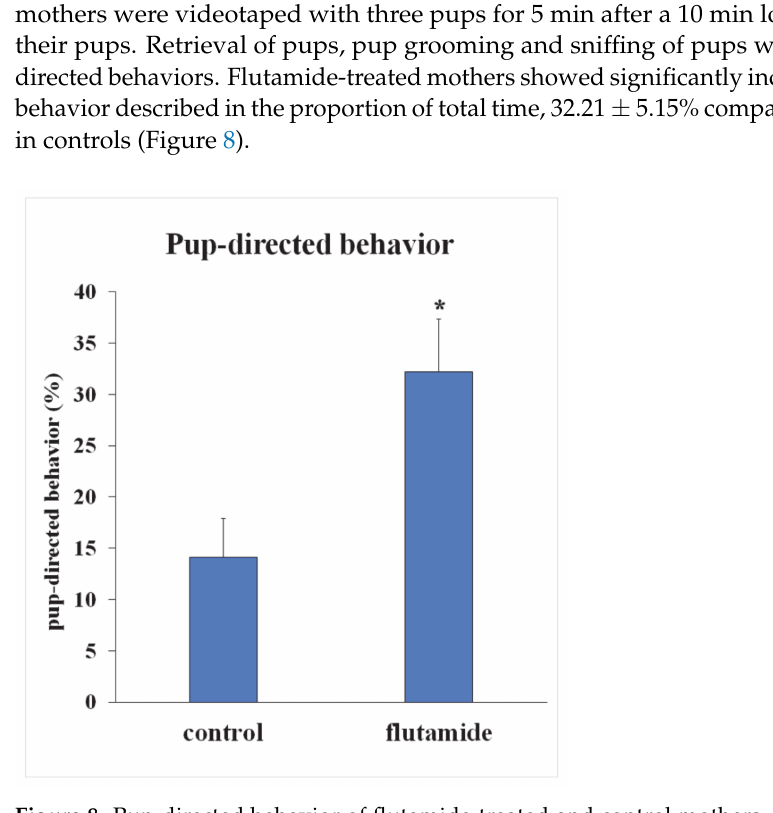
Figure 8. Pup-directed behavior of flutamide-treated and control mothers. Flutamide, a selective non-steroid antagonist of AR, was continuously administered icv. with a 0.5 mL/h speed via osmotic minipumps. One group of lactating mothers (n = 9) received flutamide and the control group (n = 9) received vehicle. On the sixth day postpartum, maternal behavior was analyzed. Retrieval of pups, pup grooming, nest building, and sniffing of pups were considered as pup-directed behaviors. Flutamide-treated mothers showed significantly increased pup-directed behavior shown as the ratio of total time. (* = p <